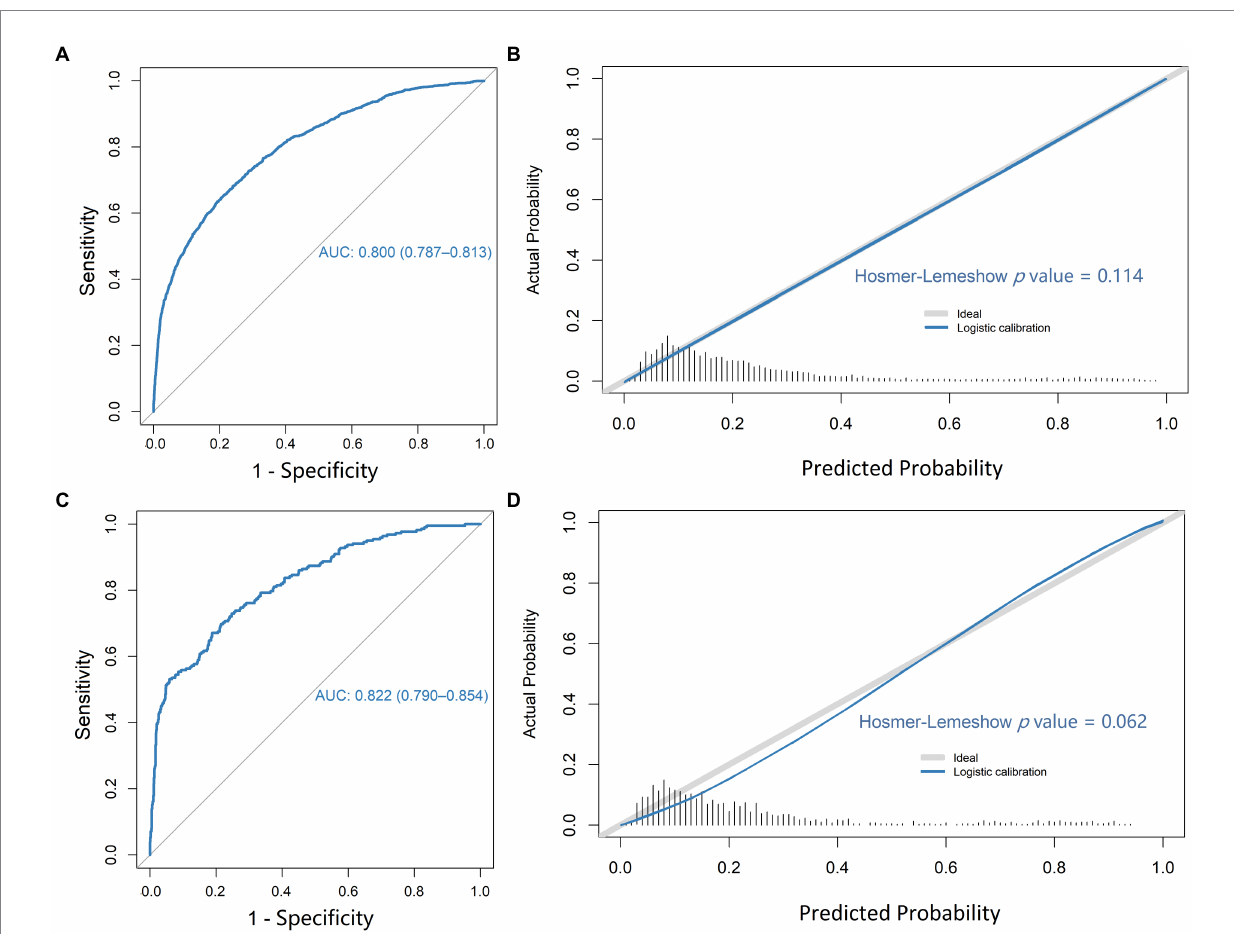
FIGURE 2 ROC plot and calibration of the logistic regression model. ROC plot (A) and calibration curve (B) for predicting patient SIRS in the training cohort; ROC plot (C) and calibration curve (D) for predicting patient SIRS in the validation cohort.